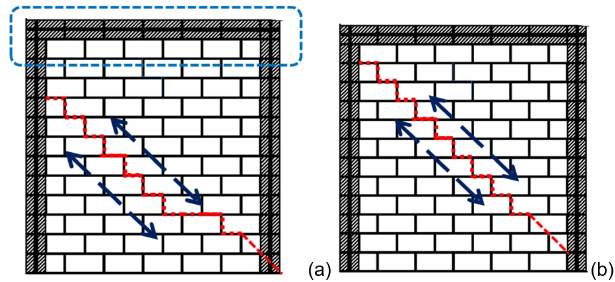
Figure 7. Cracking pattern of (a) concentrated load and (b) distributed load